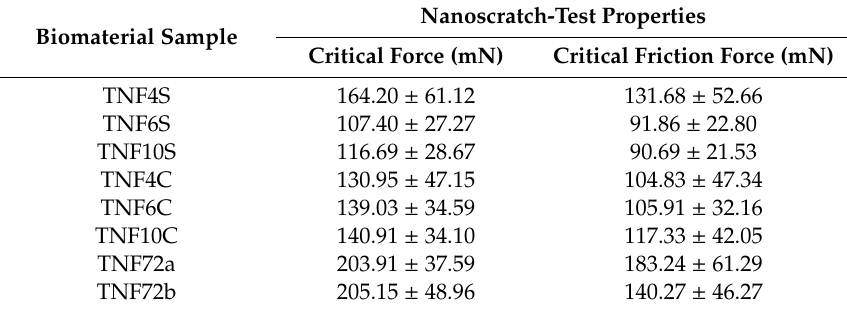
Table 2. Adhesion properties of the titanium nanocoatings to the titanium alloy surfaces. Biomaterial